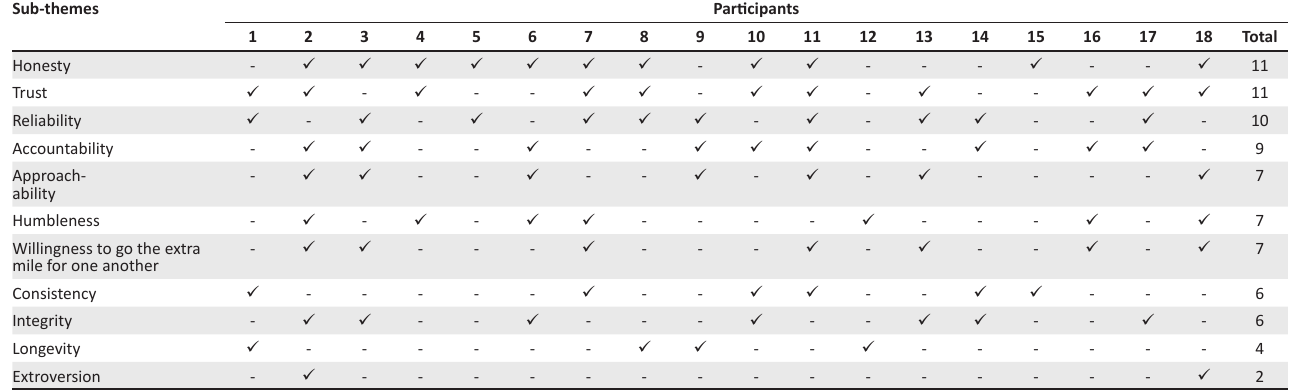
TABLE 3: Frequency of behavioural attributes required in a personal relationship to share risk information.